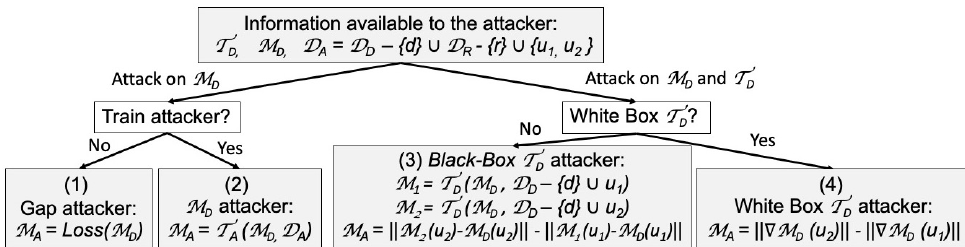
Figure 2. Taxonomy of LTU Attacker. Top: Any LTU Attacker has available the Defender trainer T M D D , the trained Defender model D , and attack data A including (almost) all the Defender data D D D = D − { membership ( d ) } ∪ D − { membership ( r ) } . However, it D and Reserved data R D R A may use only part of this available knowledge to conduct attacks. r and d are two labeled examples belonging D R and D D , respectively, and u 1 and u 2 are two unlabeled examples, one from D R and one from D D (ordered randomly). Bottom Left: Attacker M A targets only the trained Defender model M M M T D . Bottom Right: D and its trainer D A targets both